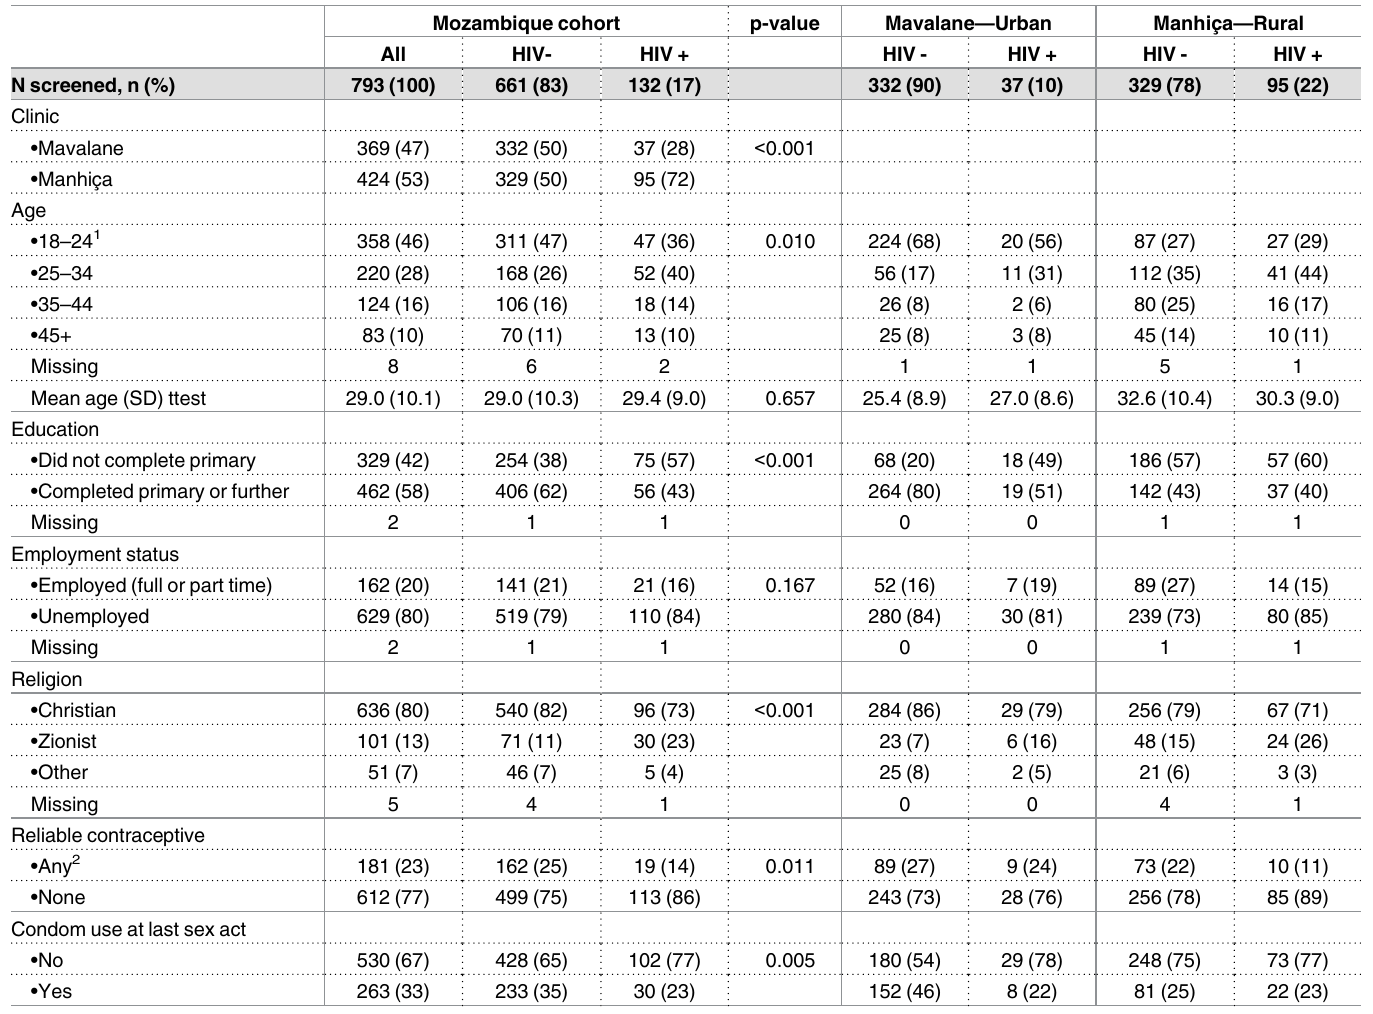
Table 1. HIV status at screening by selected demographic and sexual behavioural characteristics. Mozambique